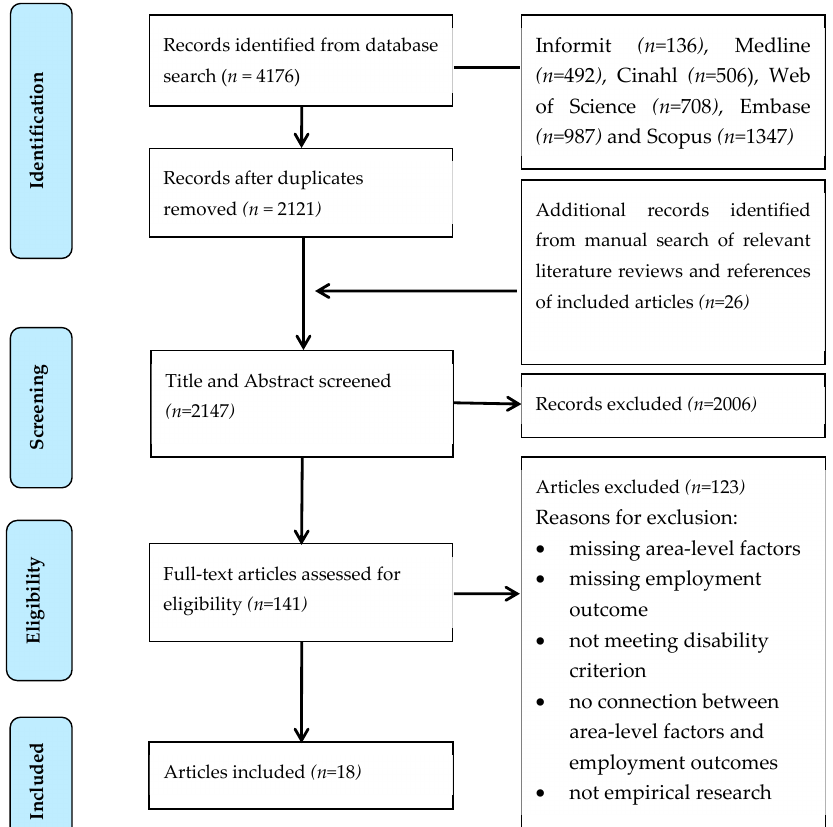
Figure 1. Literature search and screening PRISMA diagram.